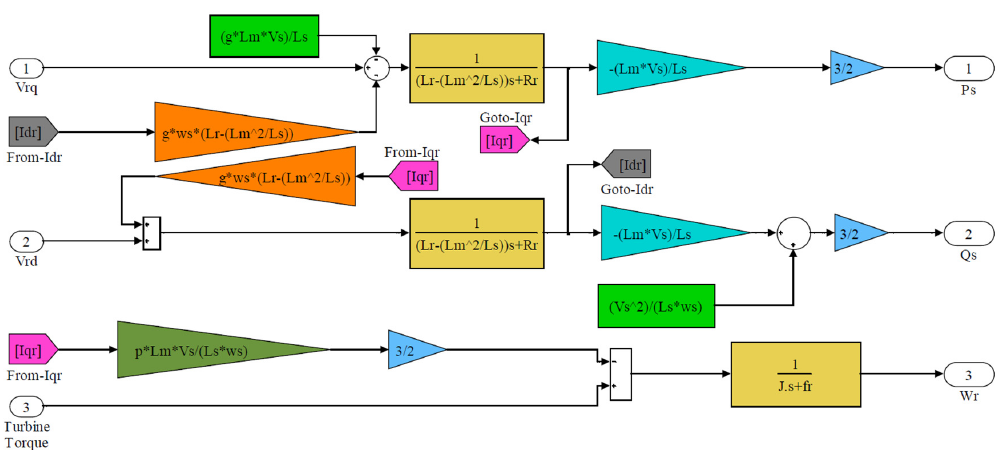
Figure 8. Transfer functions of simulated DFIG. Table 1. Operating parameters for simulation